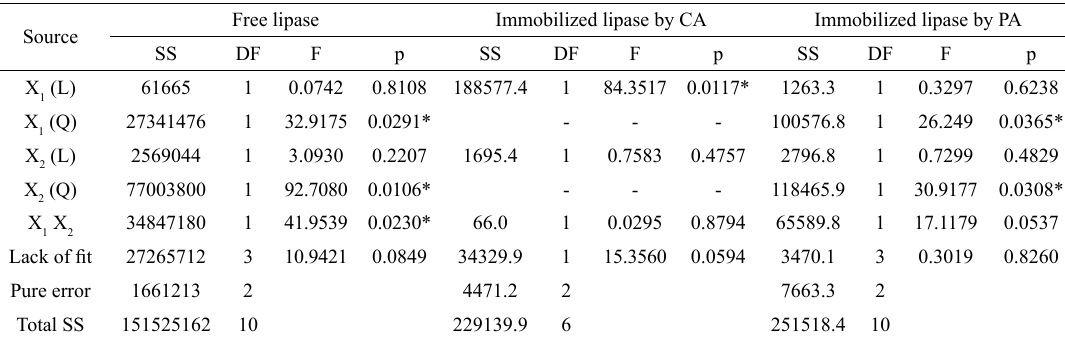
) and temperature (X ). 1 2